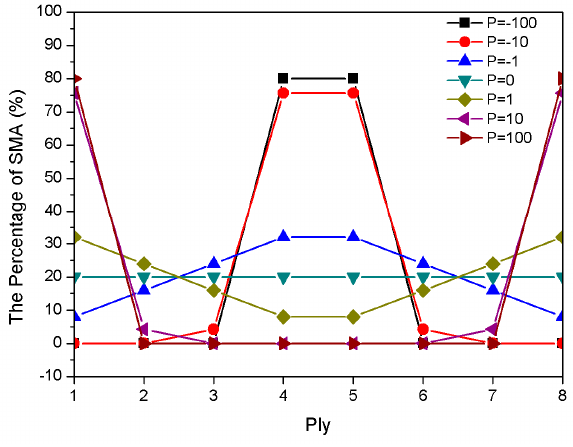
Figure 4. The percentage of SMAs in each ply.